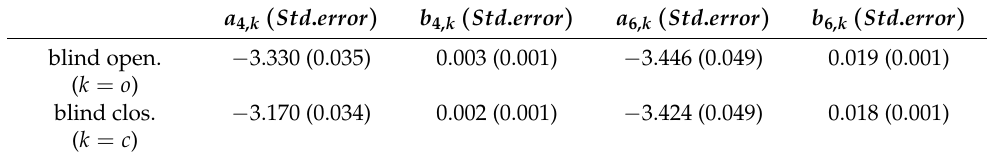
Table 2. Coefficients of the multivariate logistic regression model for blind human control. a 4, k ( Std . error ) b 4, k ( Std . error ) a 6, k ( Std . error ) b 6, k ( Std . error ) blind open. − 3.330 (0.035) 0.003 (0.001) − 3.446 (0.049) 0.019 (0.001) ( k = o ) blind clos. − 3.170 (0.034) 0.002 (0.001) − 3.424 (0.049) 0.018 (0.001) ( k = c